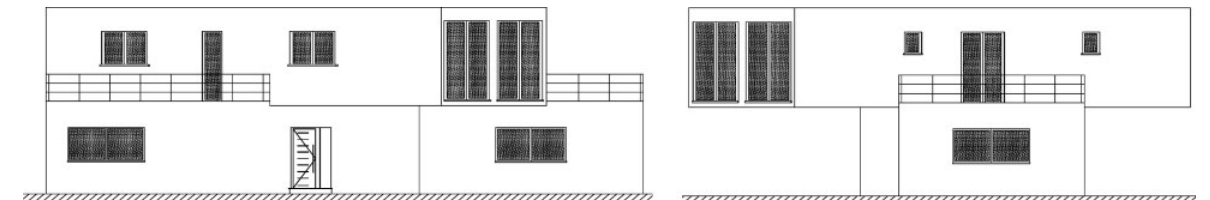
Fig. 8. Single family house: lateral views